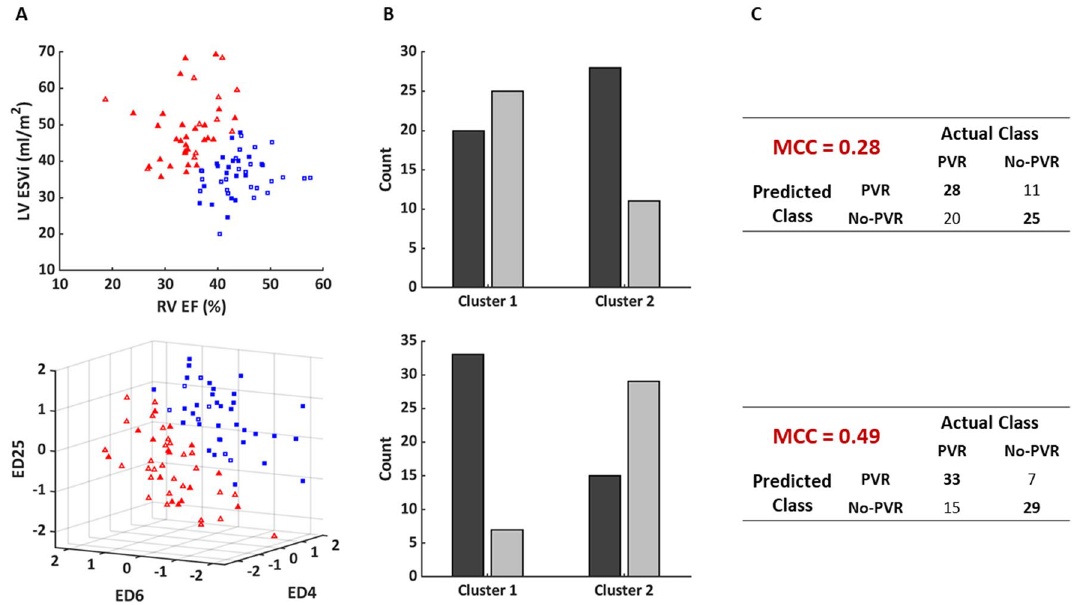
Figure 3. Summary clustering results depicting the ability of imaging indices (top) and shape modes (bottom) to discriminate PVR status. ( A ) K-means clustering using features with the most significant associations with PVR status with two clusters (blue squares: cluster 1; red triangles: cluster 2; filled: PVR; open: No-PVR). ( B ) Number of patients in the PVR (dark gray bars) and No-PVR (light gray bars) cohorts in each cluster. ( C ) Matching matrix and MCC performance metric for classifying patients by PVR status. EF Ejection fraction, ESVi End-systolic volume index, LV Left ventricular, MCC Matthews correlation coefficient, RV Right